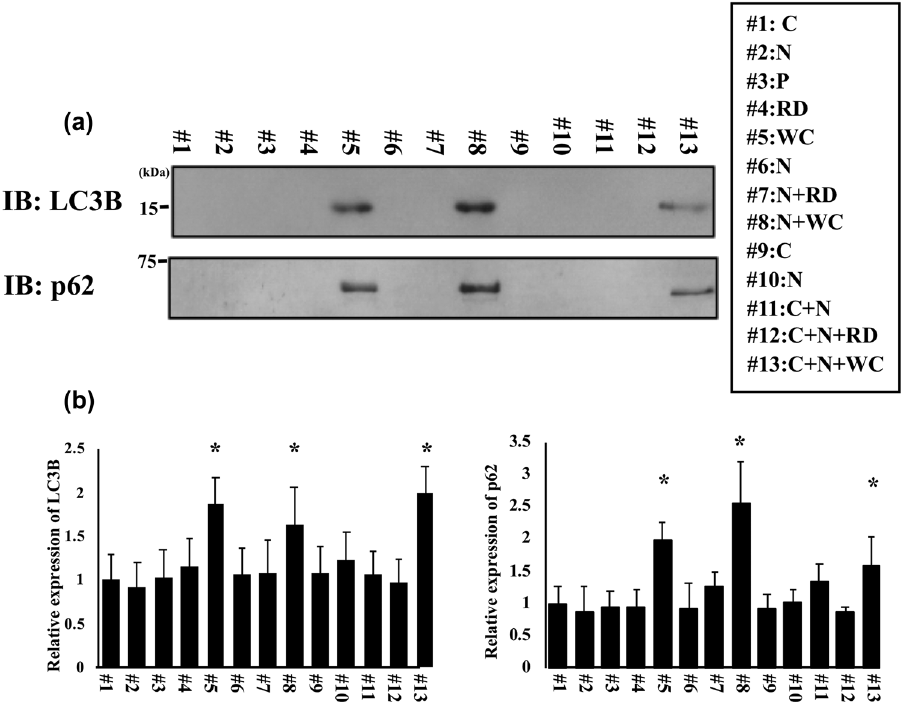
Figure 4: Protein levels were analyzed in cataract patients. ( a ) LC - 3 protein level and p62 protein level were analyzed by the western blot analysis. C: COR patient, N: NUC patient, P: PSC patient, RD: retrodots cataract patient, WC: waterclefts cataract patient, N + RD: NUC with RDs, N + WC: NUC with WC, C + N: COR with NUC, C + N + RD: COR with nuclear and RDs cataracts, and C + N + WC: COR with nuclear and WC cataracts. ( b ) Band intensities were quanti fi ed using NIH - ImageJ software. This experiment was used 3 – 4 independent samples per groups, and each bar indicates the mean ± SD. Statistical analysis of the data was done using the Aspin – Welch ’ s T - test, and the asterisk ( * ) indicates a p < 0.05 compared to COR lens ( #1 patient )